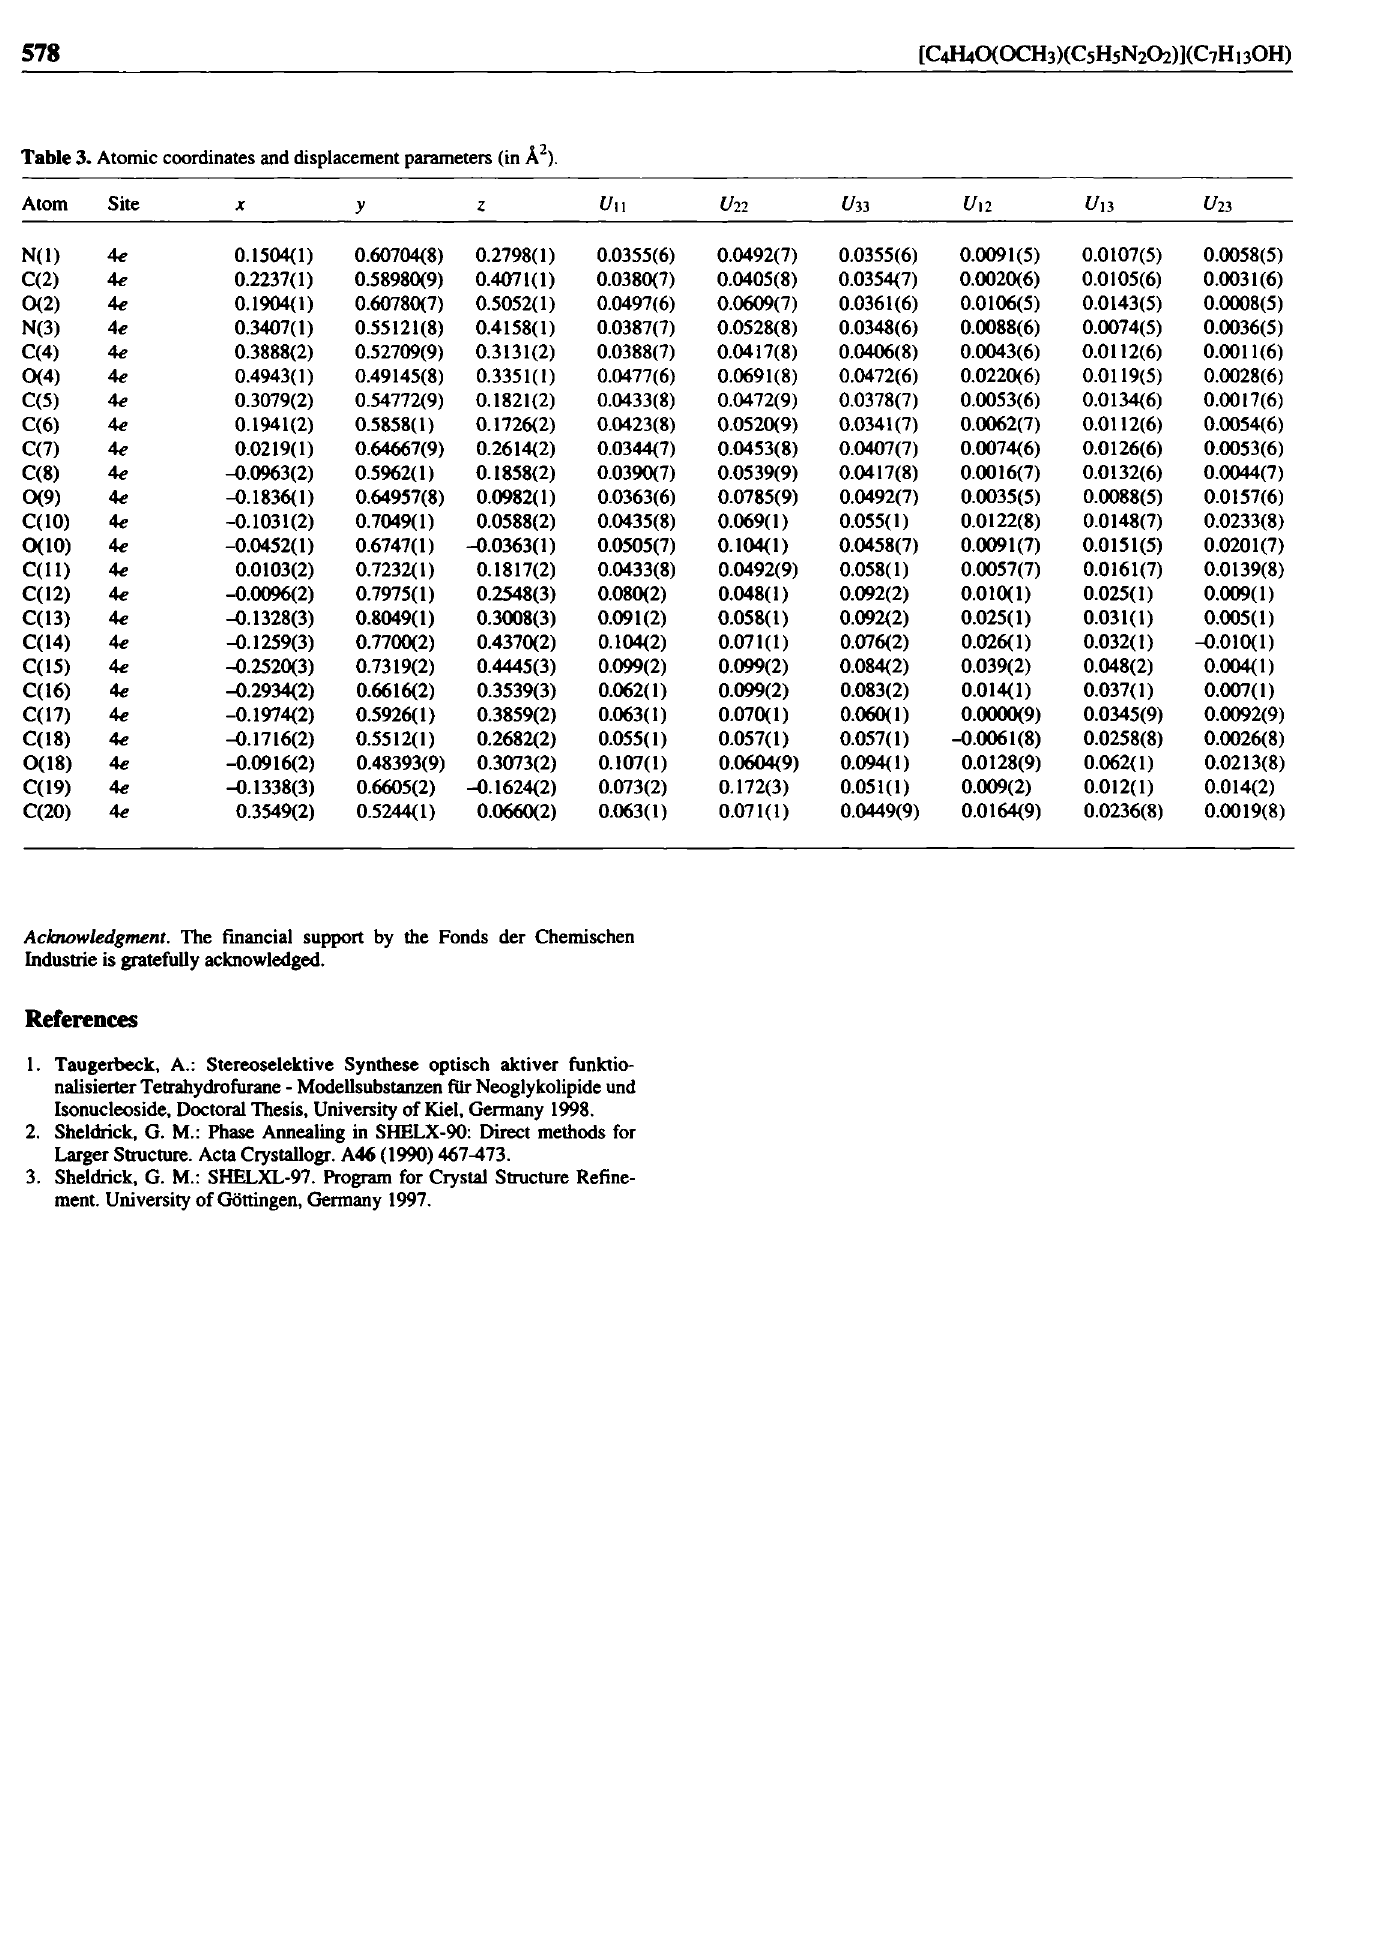
Table 3. Atomic coordinates and displacement parameters (in Â 2